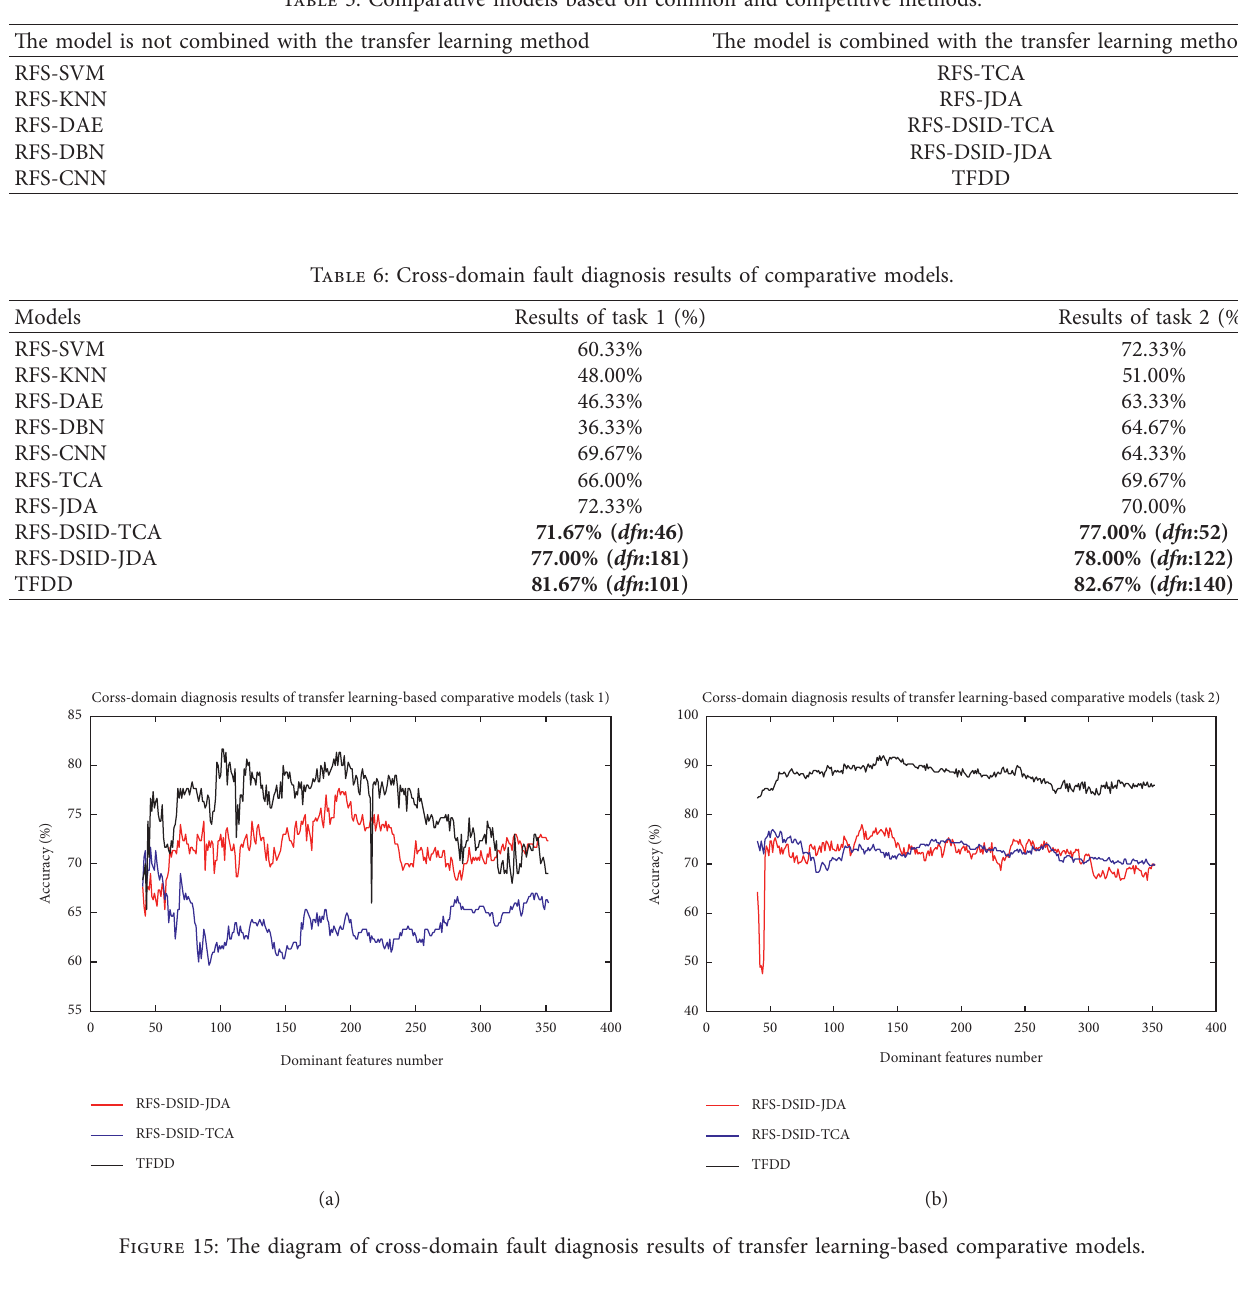
Table 5: Comparative models based on common and competitive methods.